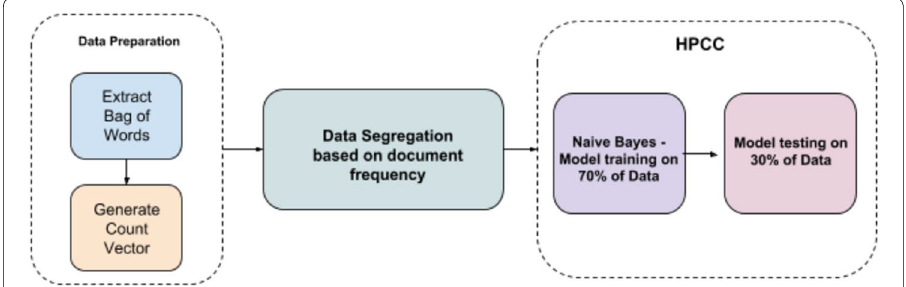
Fig. 5 Functional process